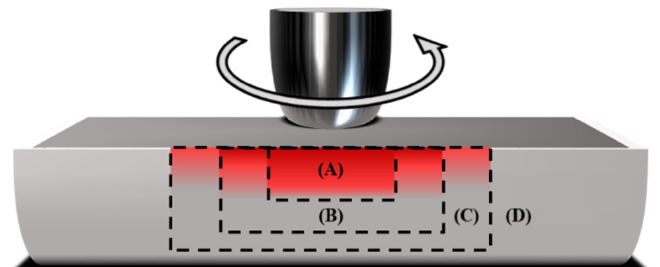
Figure 5. A depiction of the general processing zones derived from FSP. Zone A depicts the stir region (SR). Zone B is the thermomechanical affected region (TMAZ). Zone C is the heat affected zone (HAZ) and Zone D is the base material (BM).